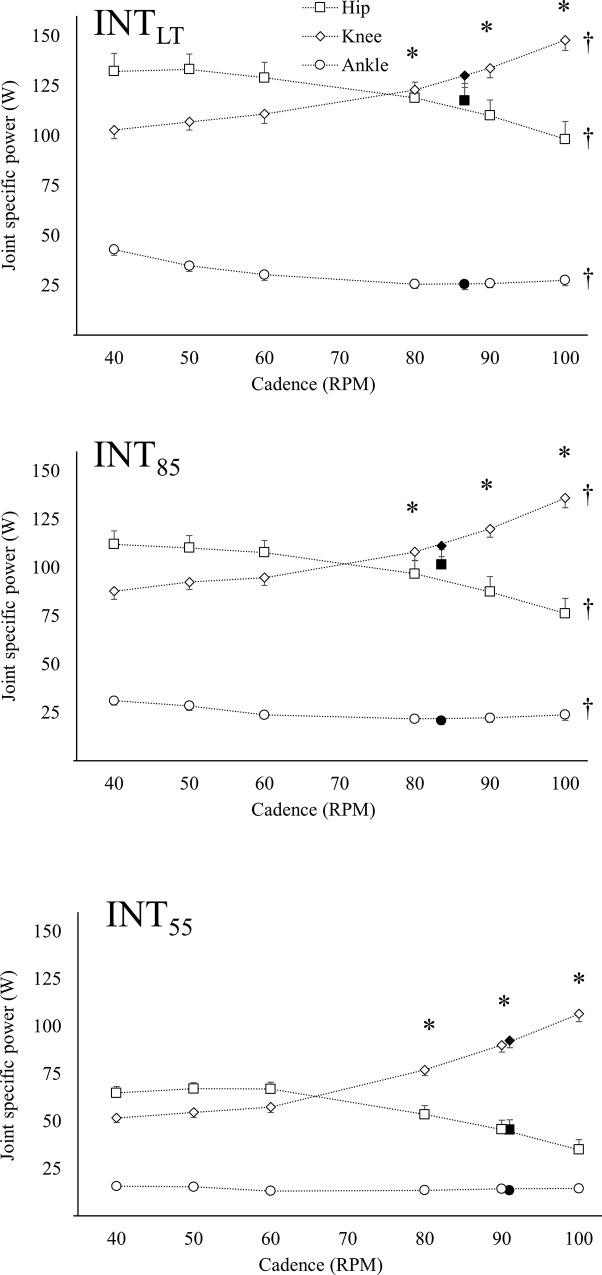
Total joint power for hip, knee and ankle joint actions.Group mean and standard error for total joint power in hip (square), knee (diamond) and ankle (circle) joint at Int55, Int85 and IntLT. Filled marker indicate FCC. * indicate a difference in joint power from previous cadence for the hip and knee joints. Daggers indicate a difference in the mean total joint power from previous intensity.